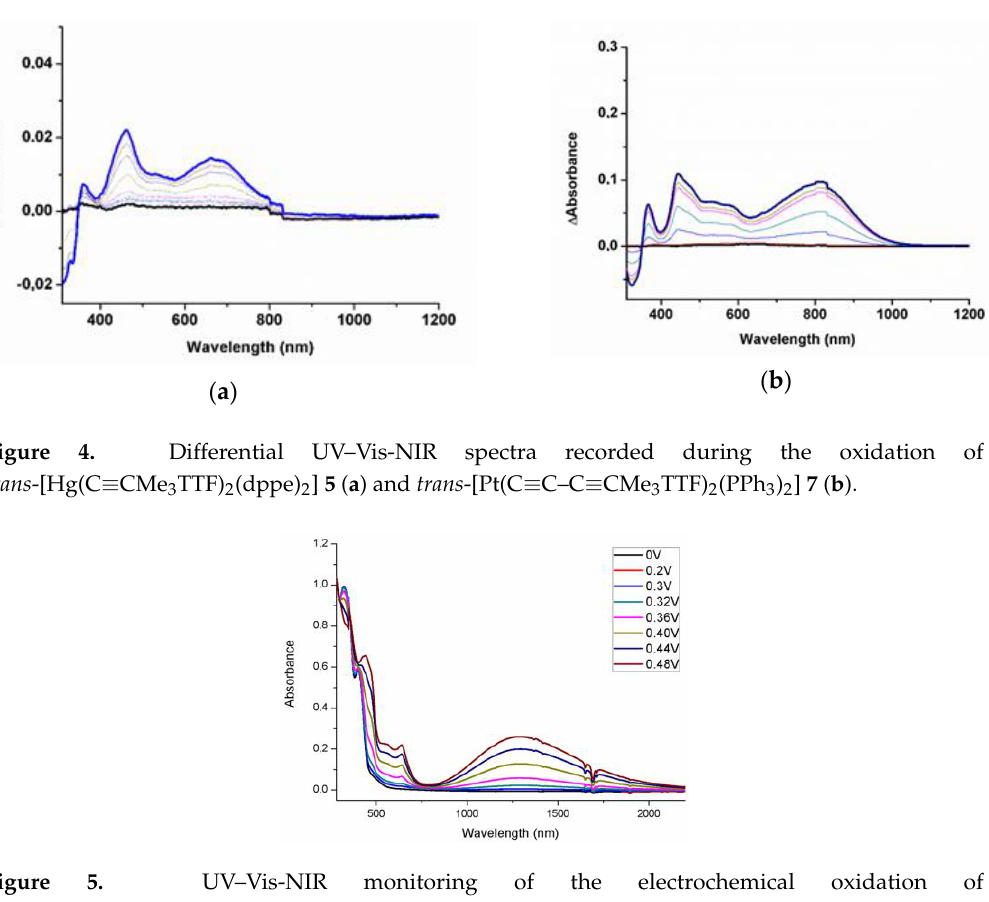
Figure 5. UV–Vis-NIR monitoring of the electrochemical oxidation of trans -[RuCl(C≡C–C≡CMe 3 TTF)(dppe) 2 ] to the monooxidized complex.